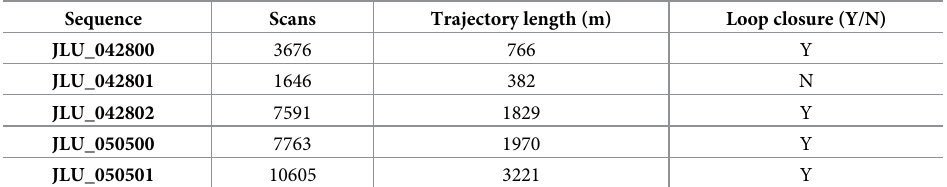
Table 2. JLU Campus dataset details.